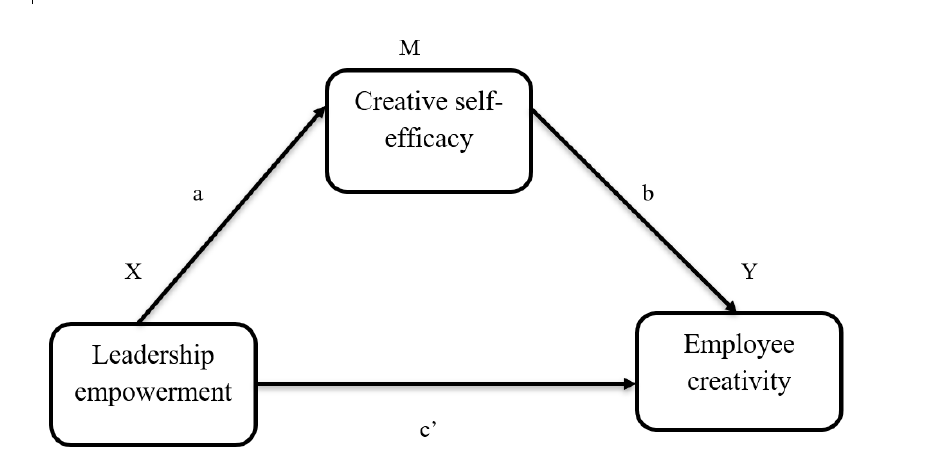
Figure 2: Mediating role of Creative self-efficacy between leadership empowerment employee